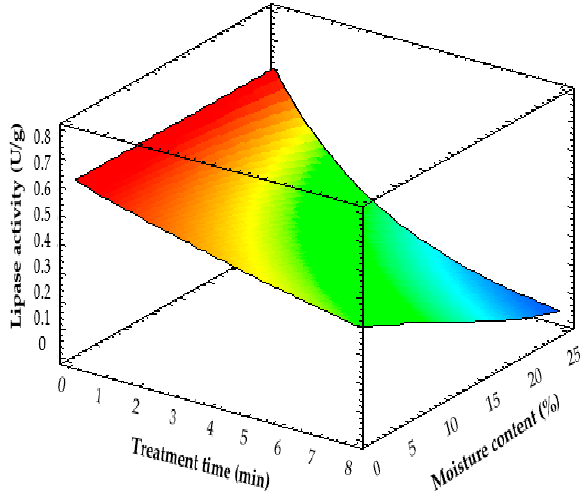
Figure Figure 2. Kinetics of lipase inactivation in tef flour via microwave treatment depending on treatment time ( t ) and moisture content ( M ). Surface corresponds to the fitting equation: 0.62·exp(- 0.048· t ·exp(0.073· M )).